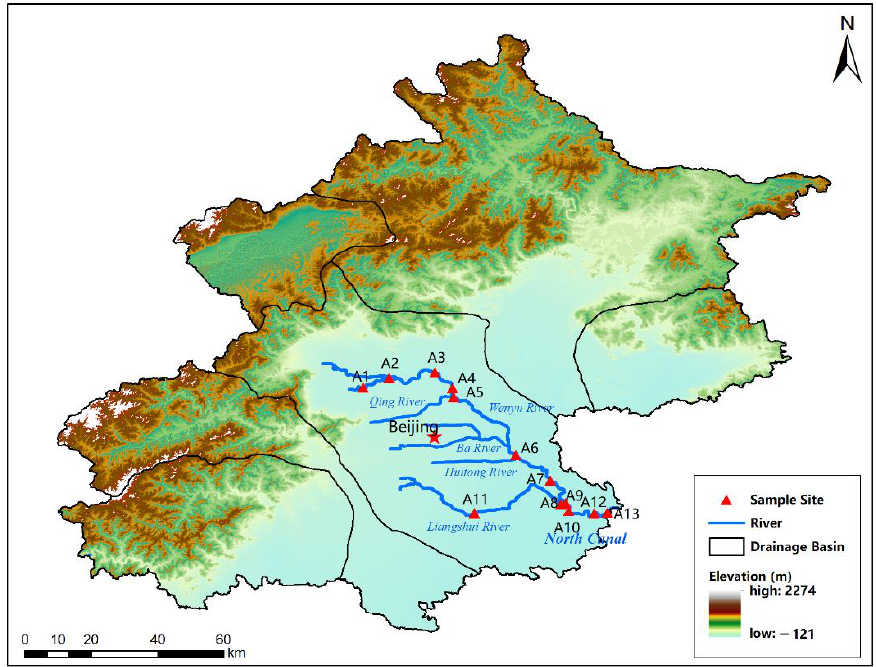
Figure 1. Schematic diagram of the study area and sampling point location.